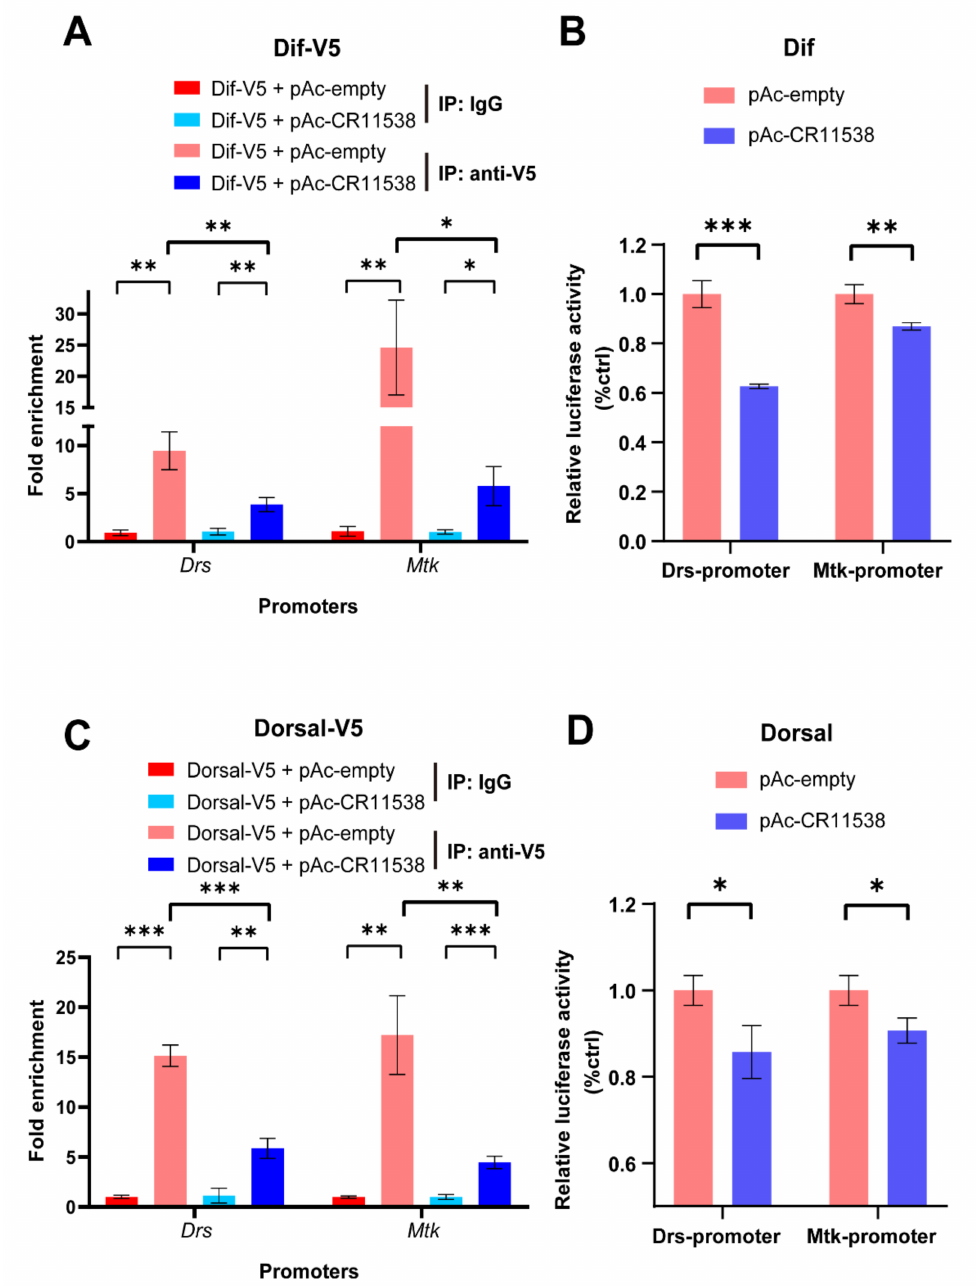
Figure 5. LncRNA-CR11538 prevents Dif/Dorsal from binding to AMP promoters and inhibits their transcriptions. ChIP- qPCR was performed on lncRNA-CR11538 overexpressing S2 cells with Dif-V5 ( A ) and Dorsal-V5 ( C ) overexpression normalized to control expression levels. The dual luciferase reporter assay detected transcriptional activity of Dif ( B ) and Dorsal ( D ) with or without lncRNA-CR11538 overexpressing on Drs and Mtk promoters. For all tests, p value < 0.05 was considered as statistically significant. * p < 0.05; ** p < 0.01 and *** p < 0.001 vs. the control